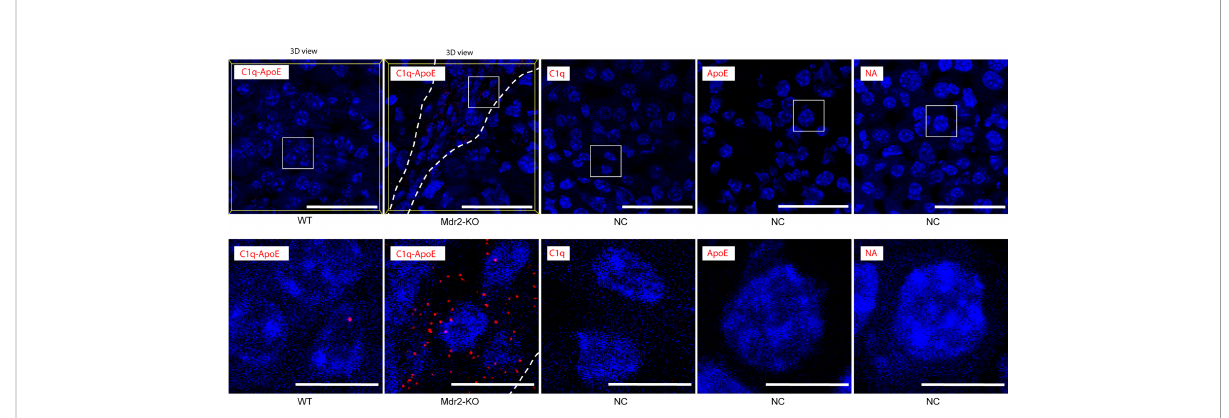
FIGURE 4 C1q-ApoE complex formation in WT and Mdr2-KO mouse livers. WT mouse liver sections were stained with C1q and ApoE by PLA. Anti-ApoE alone, Anti-C1q alone or no primary antibodies were used as negative controls. Dotted lines demarcate immune cell in fi ltrations from adjacent liver parenchyma. White square areas represent high magni fi cation images below. 3Dview images are available as mp4 videos in supplements. Representative images of WT livers (n=6); Mdr2-KO livers (n=6) are shown. Scale bar 50 m m in low magni fi cation images and 10 m m in images of high magni fi cation.